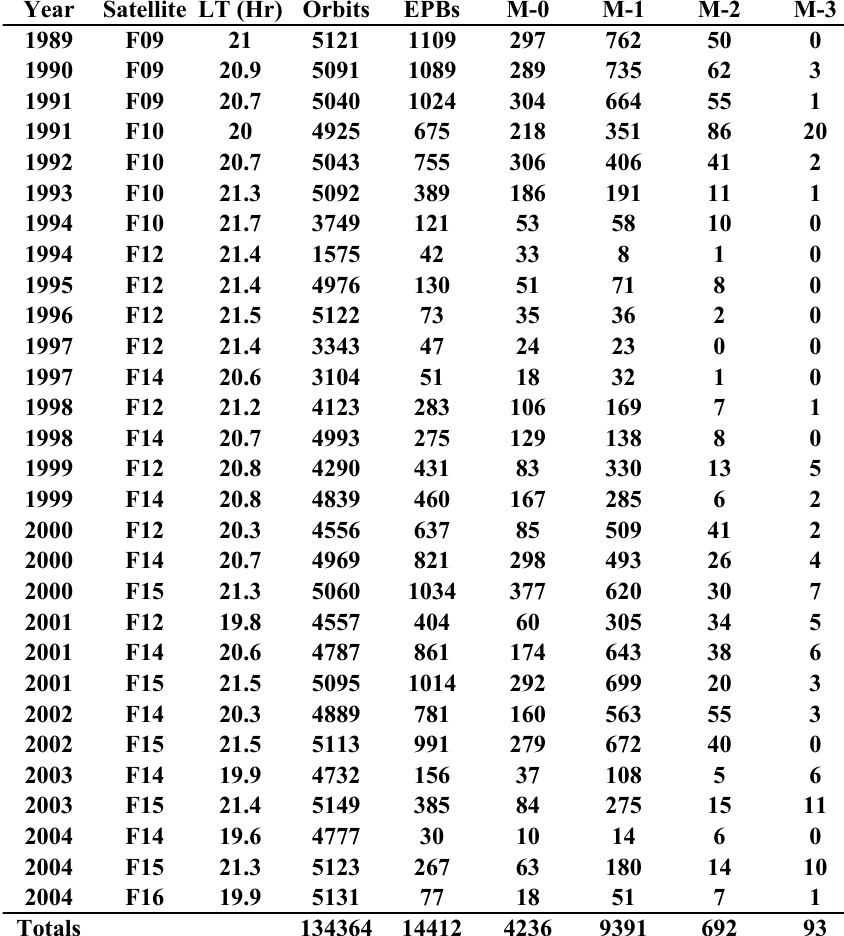
Table 1. Summary of DMSP EPB observations by year, spacecraft, LT of spacecraft orbit, number of orbits, number of orbits with EPBs, and number of orbits with EPBs classified by the depth of the deepest depletion δ N with respect to the nearby undisturbed plasma